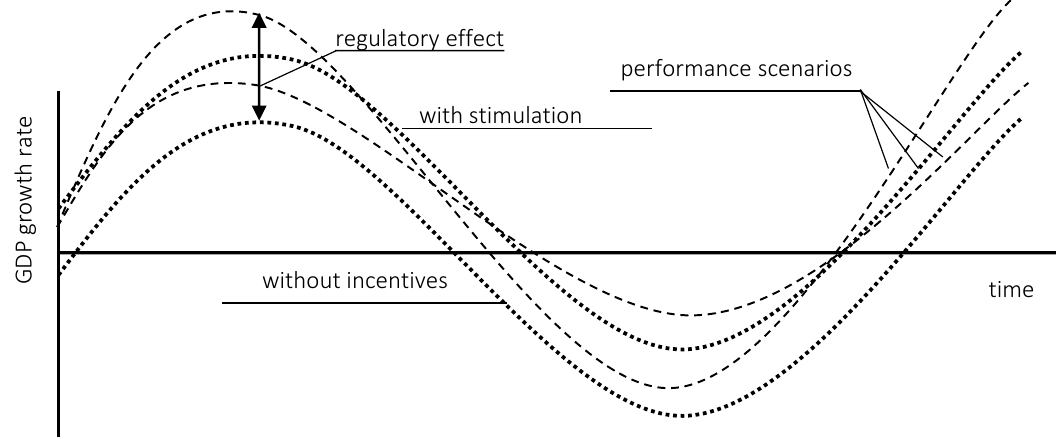
Figure 5. Conceptual model of cyclical GDP